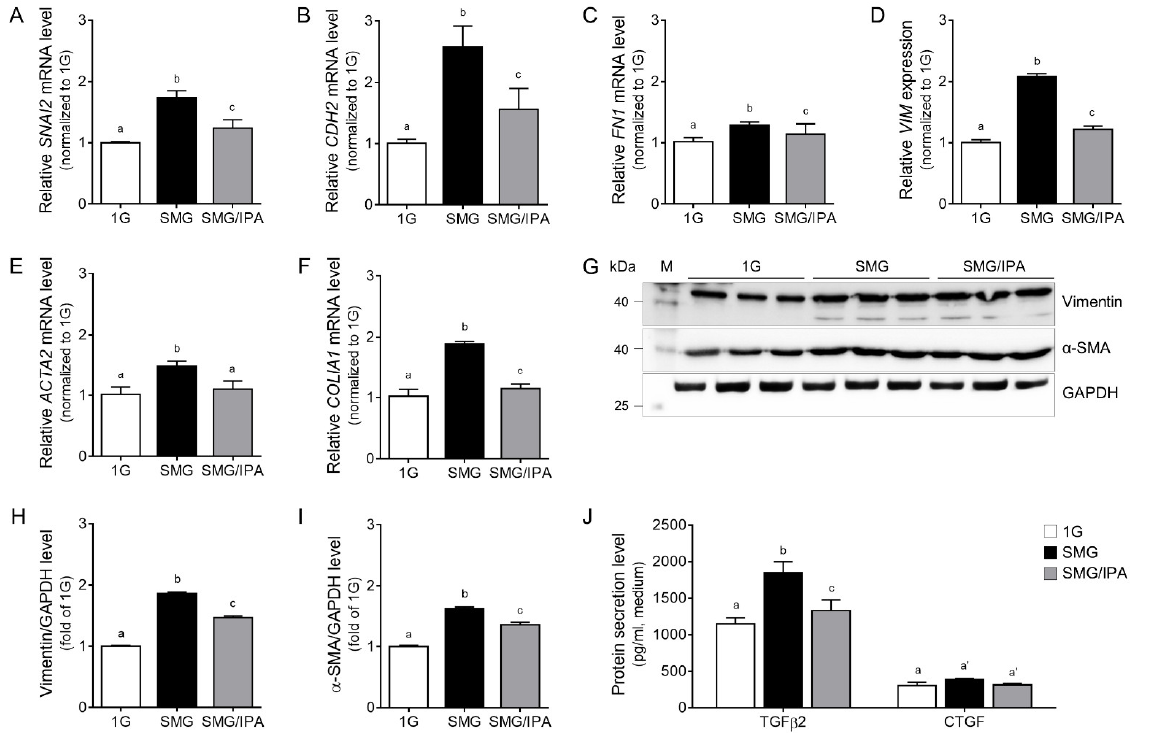
Figure 5. The inhibitory effects of the EMT process in IPA-treated microgravity-stimulated ARPE19 cells. ( A – F ) EMT-related factor mRNA levels in 1G- (white), SMG- (black), or SMG/IPA-treated (gray) ARPE19 cells were measured by qRT-PCR analysis. ( G – I ) Vimentin (encoded by VIM) and α-SMA (encoded by ACTA2) protein expression levels in 1G- (white), SMG- (black), or SMG/IPA-treated (gray) ARPE19 cells were measured by Western blot analysis. ( J ) Secreted proteins, TGFβ2 and CTGF, in the ARPE19 cell culture medium were measured by ELISA. Means denoted by differ- ent letters indicate significant differences between the groups ( p < 0.05). ACTA2, Actin Alpha 2, Smooth Muscle; CDH2, cadherin 2; COLIA1, collagen type 1 alpha 1; CTGF, connective tissue growth factor; FN1, fibronectin 1; GAPDH, glyceraldehyde 3-phosphate dehydrogenase; IPA, isho- phloroglucin A; SMG, simulated microgravity; SNAI2, Snail family transcriptional repressor 2; TGFβ2; transforming growth factor beta 2; VIM, vimentin. Next, we checked transforming growth factor beta 2 (TGFβ2) and connective tissue growth factor (CTGF) in the ARPE19 cell culture medium. These two factors are repre- sentative of EMT regulators [38]. Especially the TGFβ2 secretion level increased in the conditioned medium, but there was no significant CTGF secretion in SMG. IPA treatment decreased the TGFβ2 secretion level from ARPE19 cells, as shown in Figure 5J. 3.5. IPA Reduced Abnormal Migration and EMT in VEGF-Treated ARPE19 Cells We confirmed that VEGF expression and secretion by microgravity stimulation in- duced EMT in ARPE19 cells, but this process could be inhibited by IPA treatment. To directly determine the function of VEGF in the RPE, we treated the ARPE19 cells with PBS (PBS group), VEGF (VEGF group), and VEGF plus IPA (VEGF/IPA group). First, we vali- dated EMT markers, including Snail 2, N-cadherin, fibronectin 1, vimentin, α-SMA, and collagen 1, via qRT-PCR. The gene expression levels of the EMT markers were higher in the VEGF group than in the PBS group, but the levels in the VEGF/IPA group were lower than those in the VEGF group (Figure 6A).